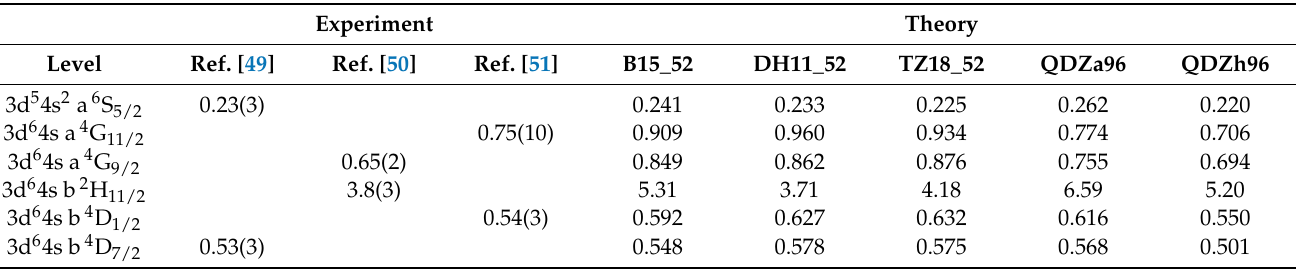
Table 12. Comparison of [Fe II ] experimental lifetimes (in s) with those derived from the revised PyNeb atom datasets. The error of the least significant figure of the observed lifetime is indicated in brackets.